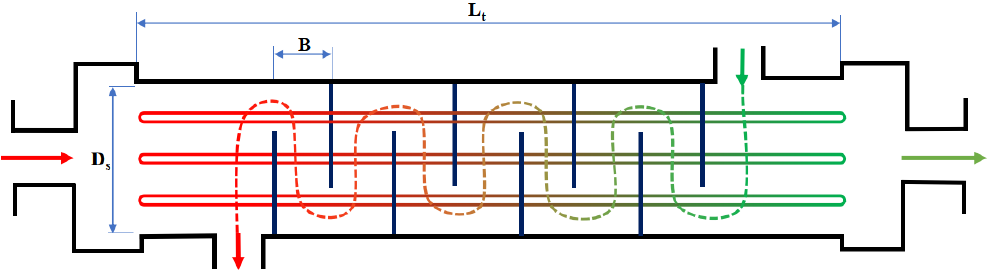
Figure 1. Schematic diagram of shell and tube heat exchanger. Table 2. Geometrical parameters of shell and tube heat exchanger studied in this work.